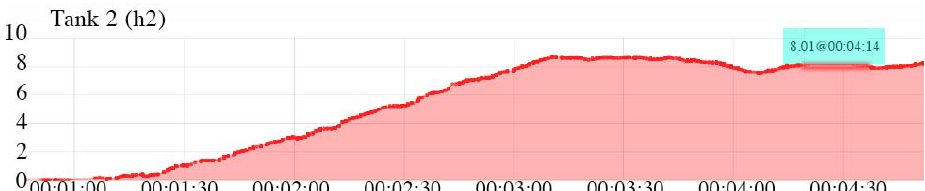
Figure 15. Waveform chart of h 2 queried from the dashboard application.